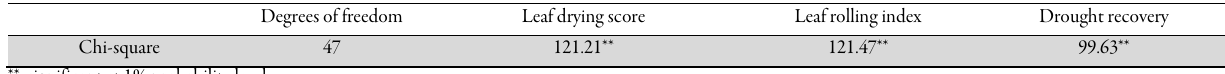
Table 4. Chi-square amount in Freedman’s Non-parametric test for ordinal measurement traits